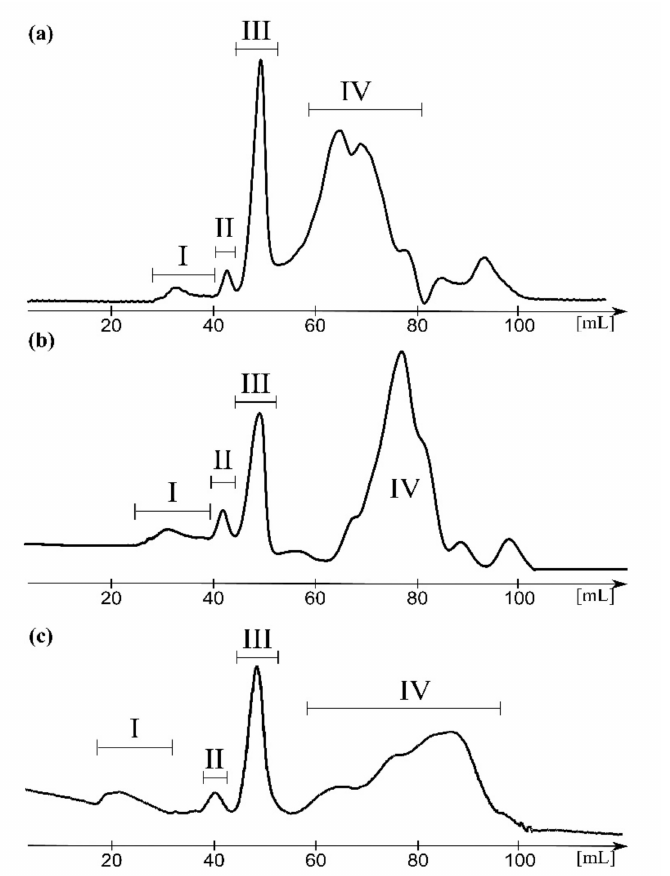
Figure 1. The Bio-Gel P-30 elution profiles of hydrolysed supernatants obtained after ultracentrifuga- tion of S. sonnei phase II ( a ), E. coli R1 ( b ), and E. coli K12 ( c ) lipopolysaccharides (LPS). Fractions I, II, III, and IV were collected and further analyzed by mass